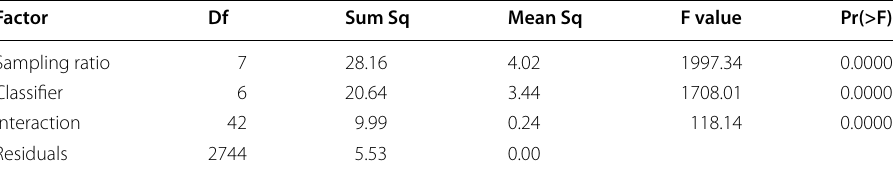
Table 20 ANOVA results for 2-factor test of classifier and sampling ratio with SQL Injection web attacks, including their interaction; in terms of AUC Factor Df Sum Sq Mean Sq F value Pr(>F)